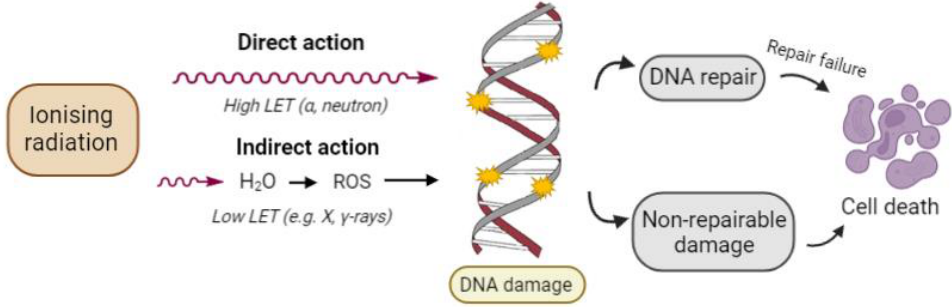
Figure 1. Direct and indirect action of ionizing radiation. In direct action—radiation directly inter- acts with DNA, causing DNA damage. In indirect action—radiation interacts with other molecules in cells, especially water molecules, producing reactive oxygen species (ROS), which induces DNA damage. DNA damage leads to cell death if not properly repaired.